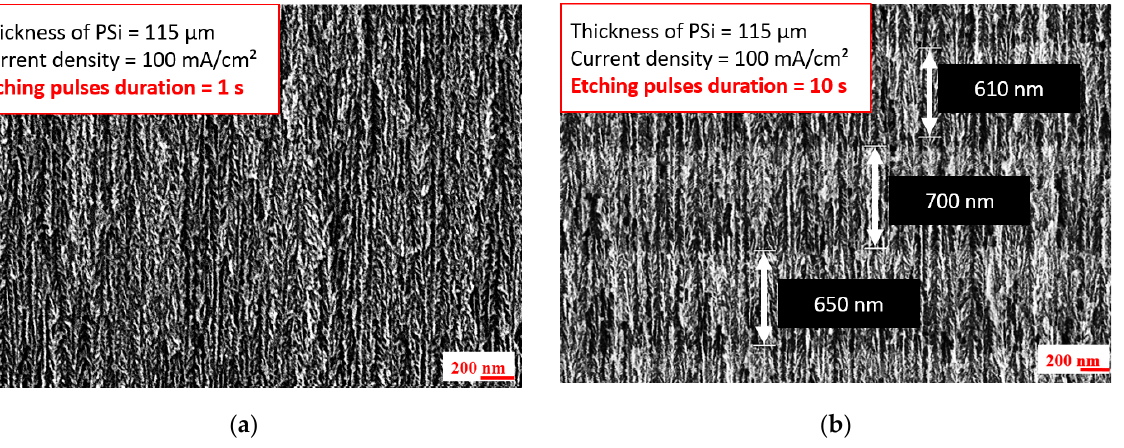
Figure 4. Focus on modulation visible in-depth for samples with a thickness of 115 µm under dif- ferent pulse duration conditions with 30,000× magnification and 15 kV: ( a ) 1 s and ( b ) 10 s. pulse duration conditions with 30,000 × magnification and 15 kV: ( a ) 1 s and ( b ) 10